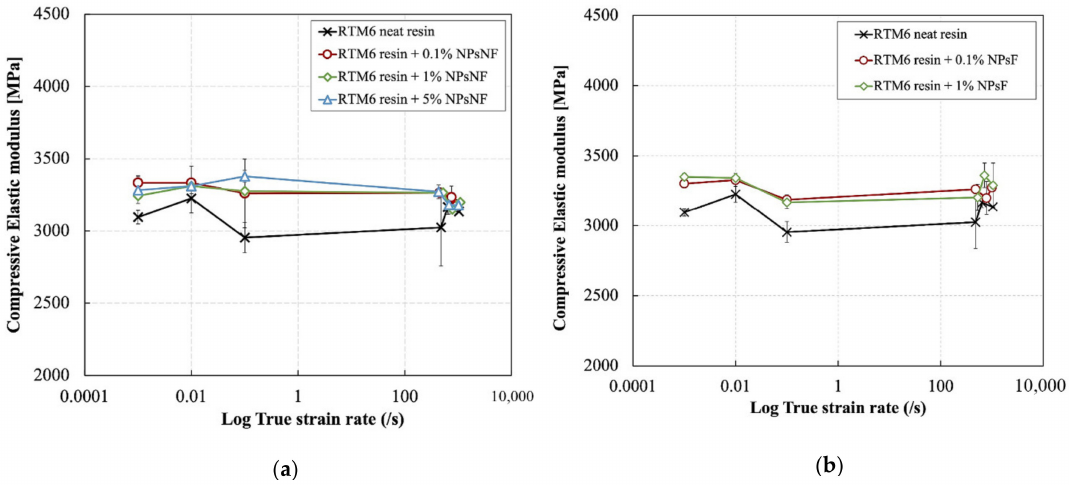
Figure 9. Effect of strain rate on the elastic modulus of the silica nanoparticle-filled epoxy at different particle weight contents and functionalization conditions: ( a ) non-functionalized and ( b )